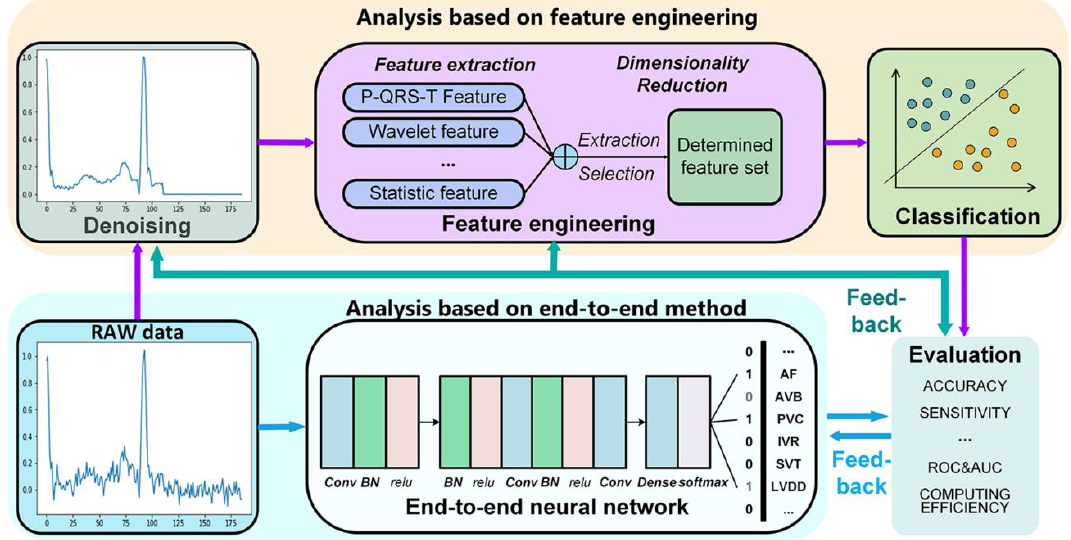
Figure 1. Process of computational diagnostic techniques for electrocardiogram signals.